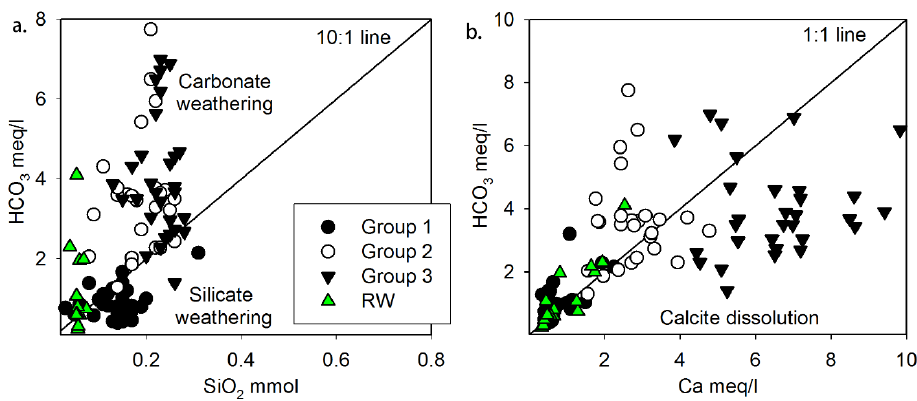
Figure 7. Assessment of the dominant water–rock interactions of the water samples plotted based on ( a ) HCO 3 vs. SiO 2 and ( b ) HCO 3 vs. Ca 2+ concentrations.